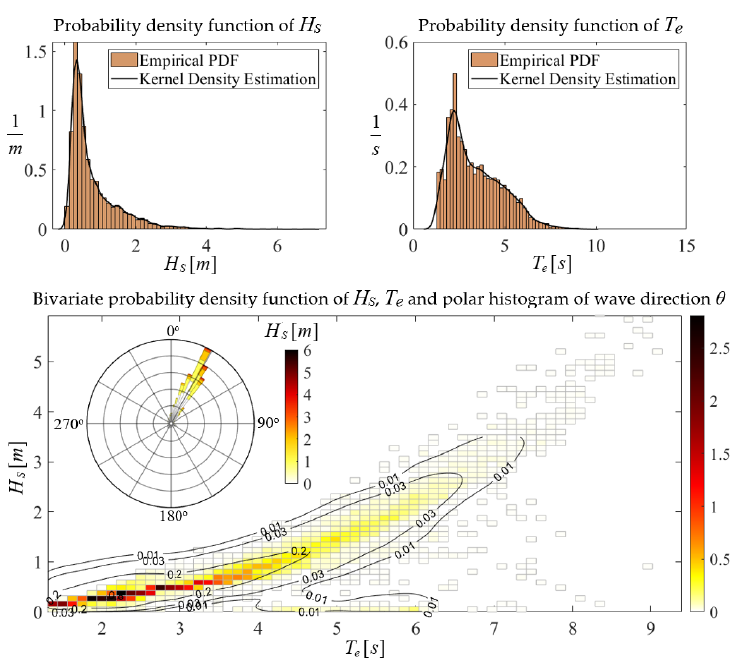
Figure 8. Annual distribution of wave parameters at the nearshore point TP5 of SE region of Evia Island. Table 1. Nearshore wave parameters associated with the wave climatology in the considered re- gions.